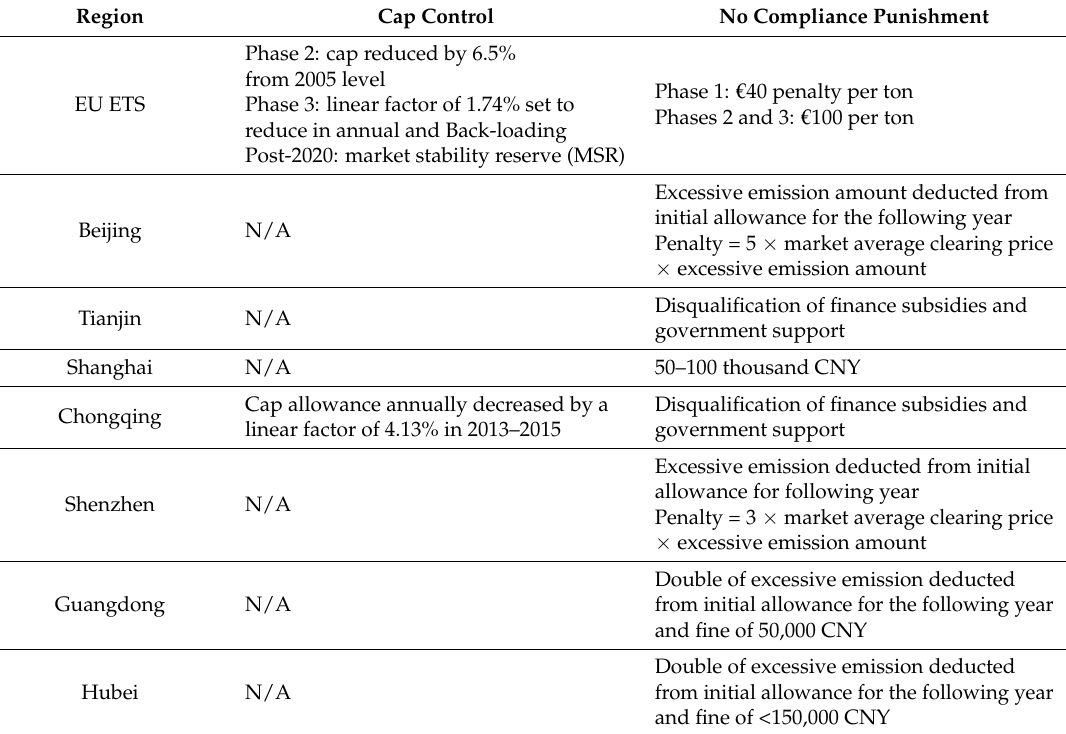
Table 9. Risk management measures in EU ETS and China’s pilot